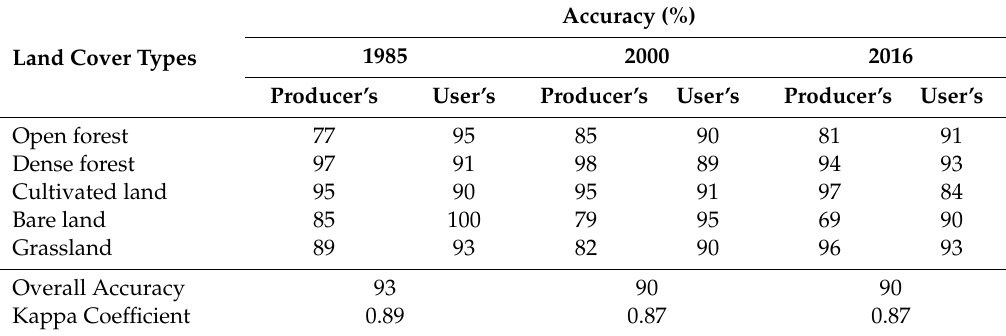
Table 2. Accuracy assessment of classified images.